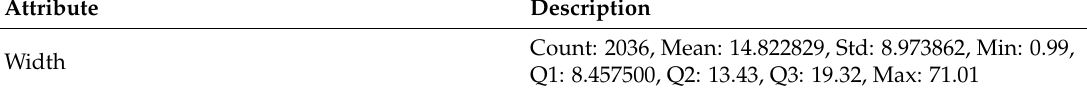
Table 1. Exploratory data analysis of the